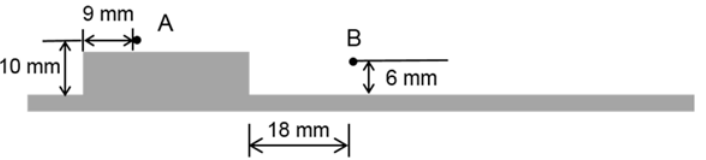
Figure 6. Sketch of the locations selected for quadrant analysis (taking 3D-cu-s as an example).